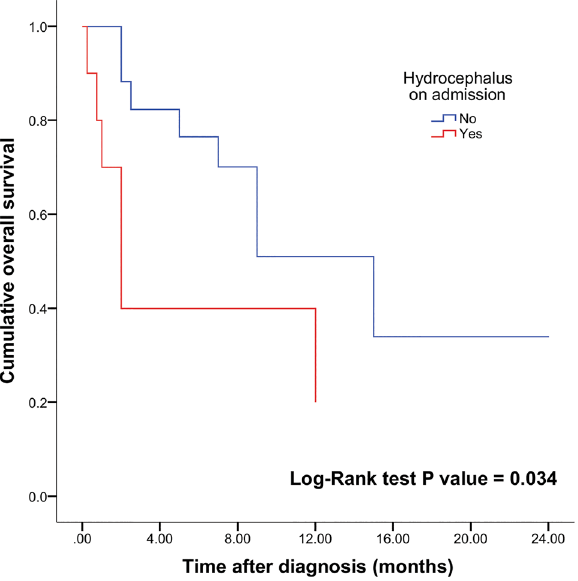
Figure 1. Kaplan–Meier plot of OS based on presence (n = 11) or absence (n = 19) of hydrocephalus in patients with CPA glioblastoma (log-rank test alpha level was 0.05). Patients with no hydrocephalus on admission had a mean OS 18.4 months compared with 5.6 months in patients with hydrocephalus on